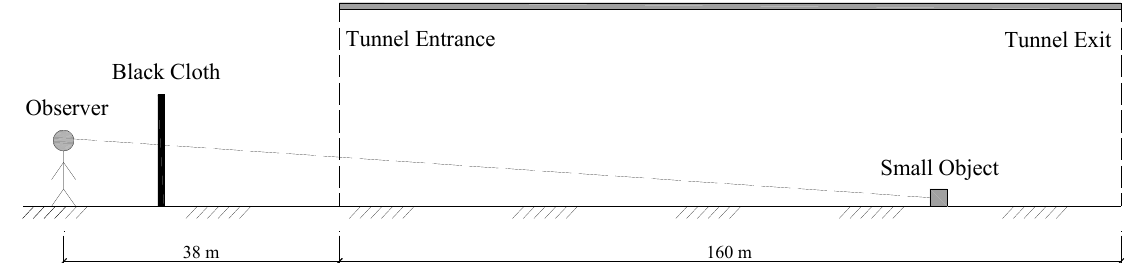
Figure 5. Visible distance test for a small object in tunnel.